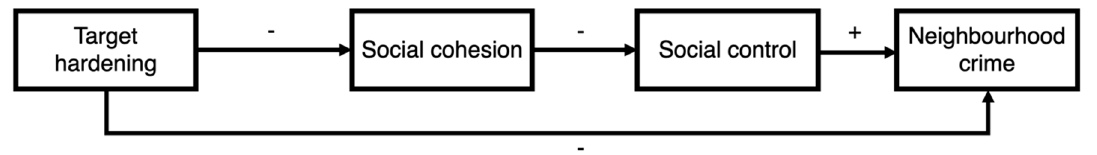
Figure 3. Pathway model illustrating the purported influence of target hardening measures on crime directly and through CE.